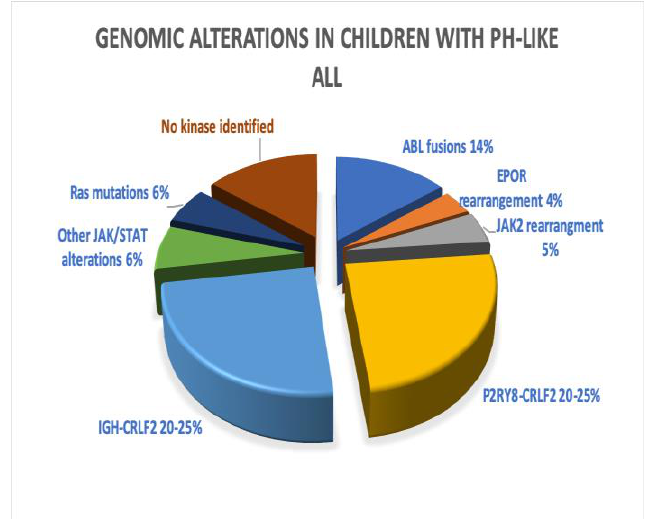
Figure 3. Genomic alterations in children with Ph-like ALL. Pie chart constructed with data from Roberts et al. and Reshmi et al. [14,32].